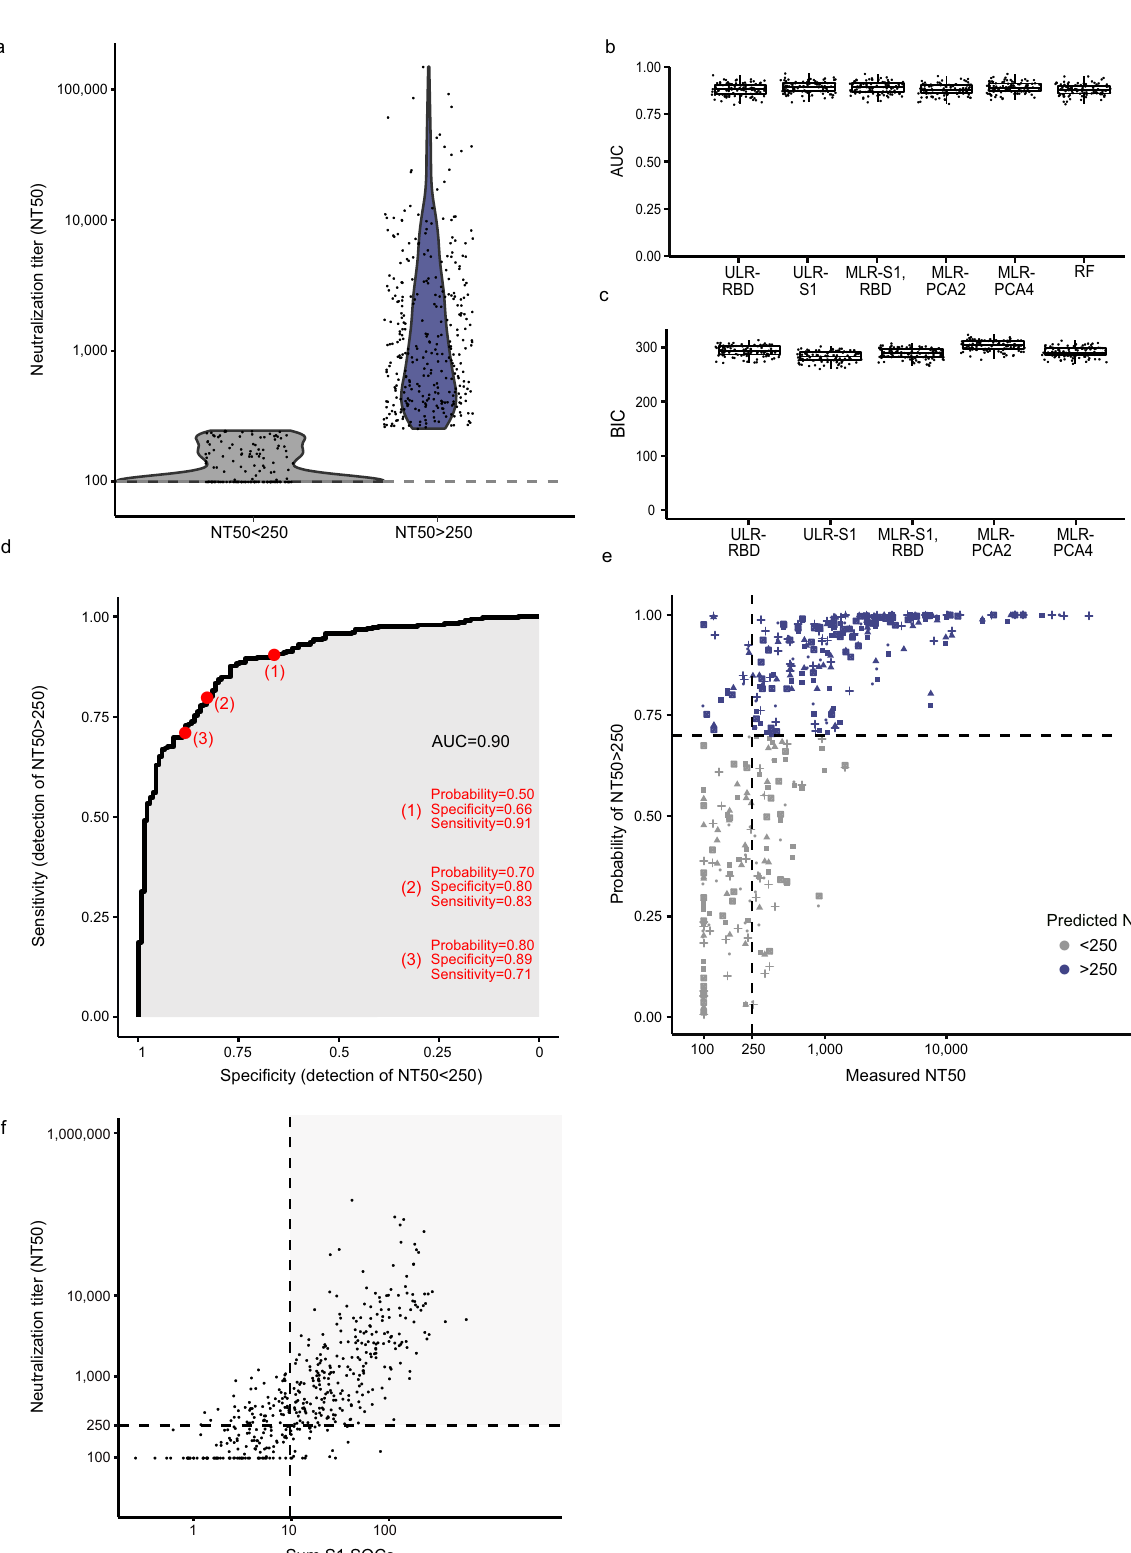
Sensitivity=0.71Probability=0.50 Specificity=0.66 Sensitivity=0.91 Probability=0.70 Specificity=0.80 Sensitivity=0.83 Probability=0.80 Specificity=0.89